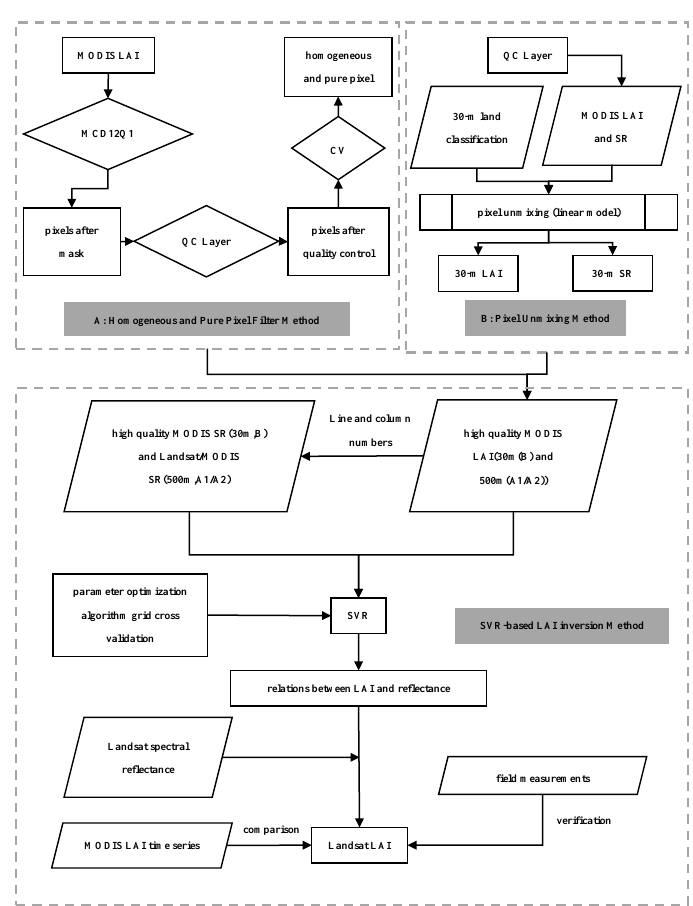
Figure 1. Data processing flowchart of the support vector regression (SVR) inversion method with two training sample-selecting methods: ( A ) the homogeneous and pure pixel filter method and ( B ) the pixel unmixing